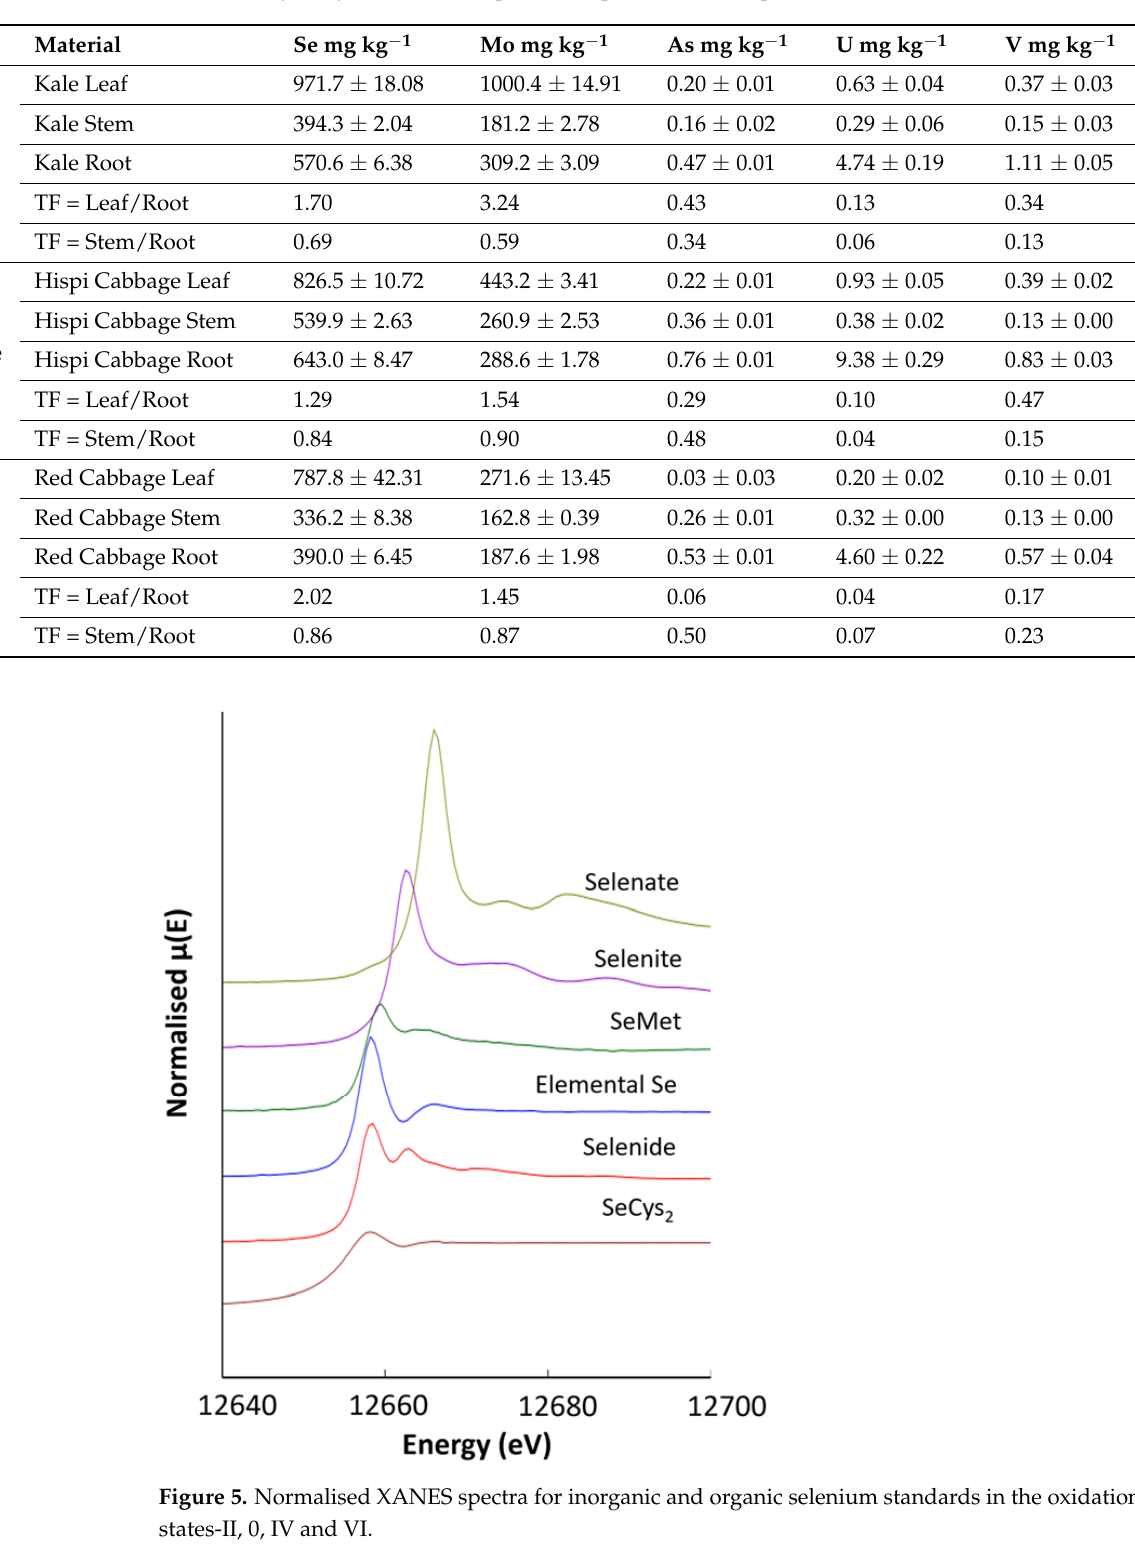
Table 4. The mean concentration of Se, Mo, As, U and V in selenium accumulator Brassica oleracea varieties from the experimental plot in a pasture in West Limerick. TF = the translocation factor; a value >1 indicates the plant can translocate the element effectively from the root to shoots, stem and leaves. Analysis by ICP-MS, all experiments performed in triplicate ± the standard error.